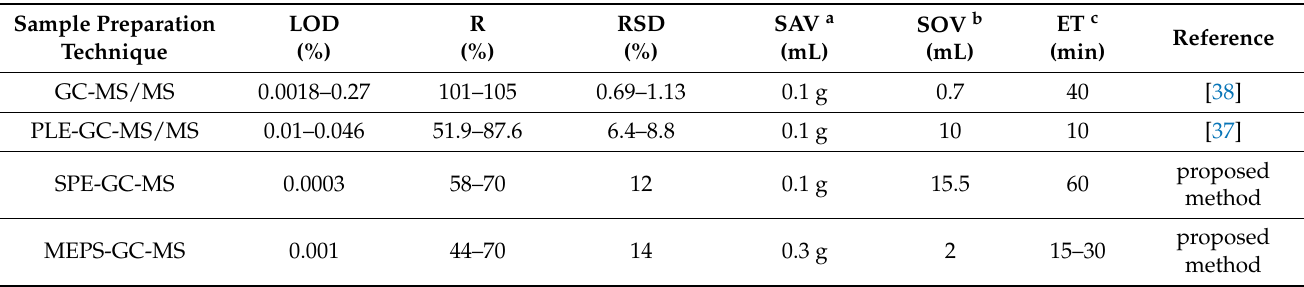
Table 5. Comparison of proposed MEPS-GC-MS and SPE-GC-MS methods to determine target analytes in cosmetic samples with other analytical methods reported in the literature.